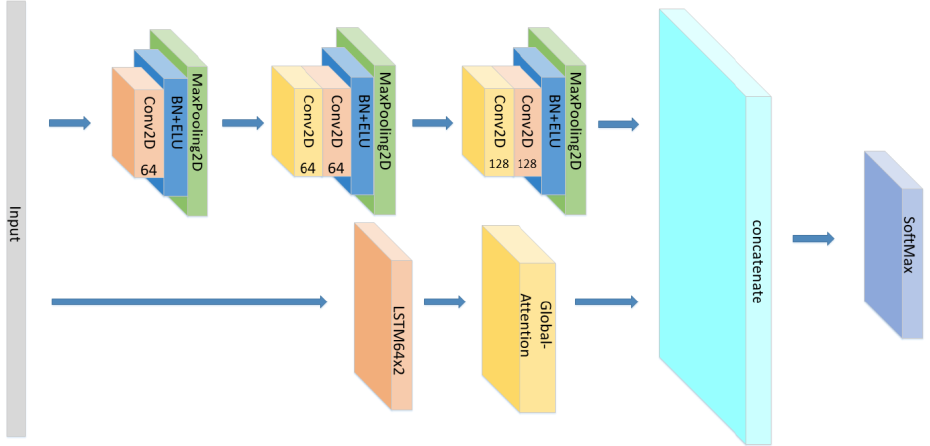
Figure 19. The structure of the CNN//LSTM×2+Self-Attention.